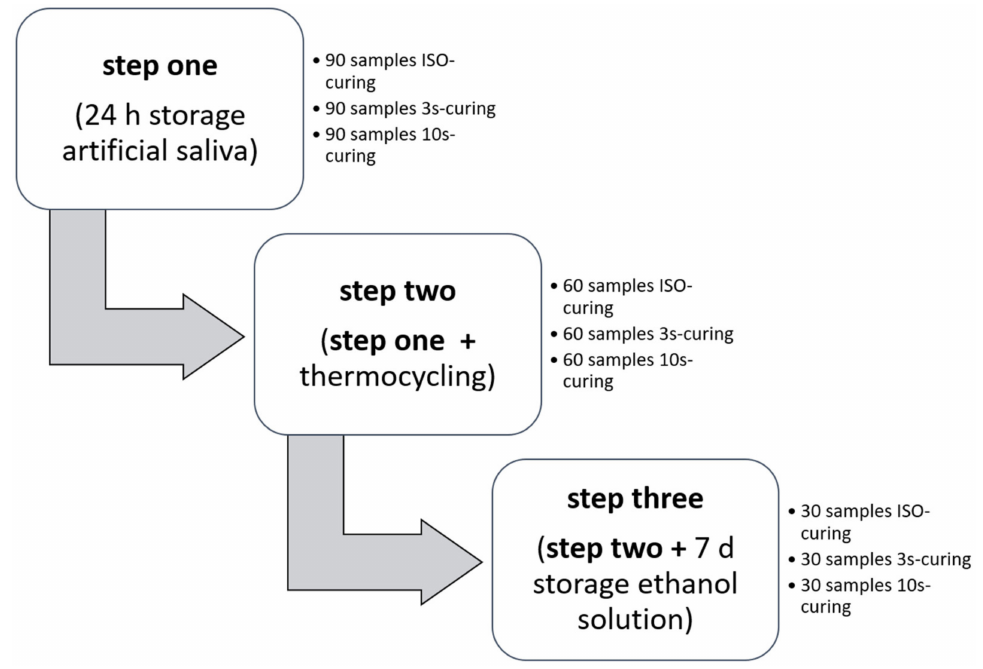
Figure 1. Flow chart of the in-vitro aging